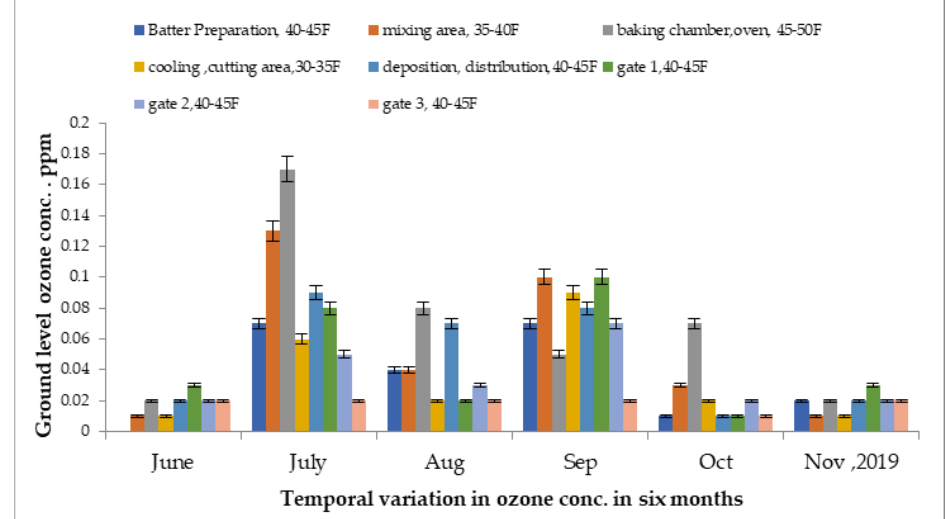
Figure 4. Variations in ground-level ozone concentrations in different units of food industry